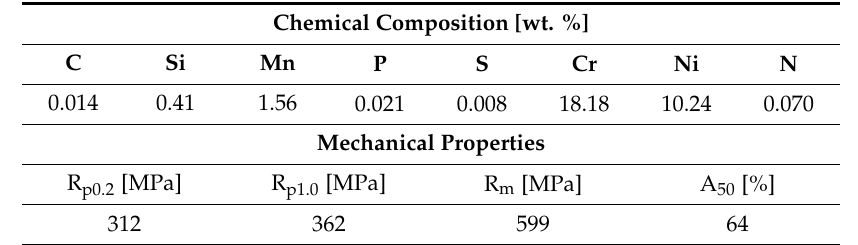
Table 1. Chemical composition and mechanical properties of 304L stainless steel according to the inspection certificate.